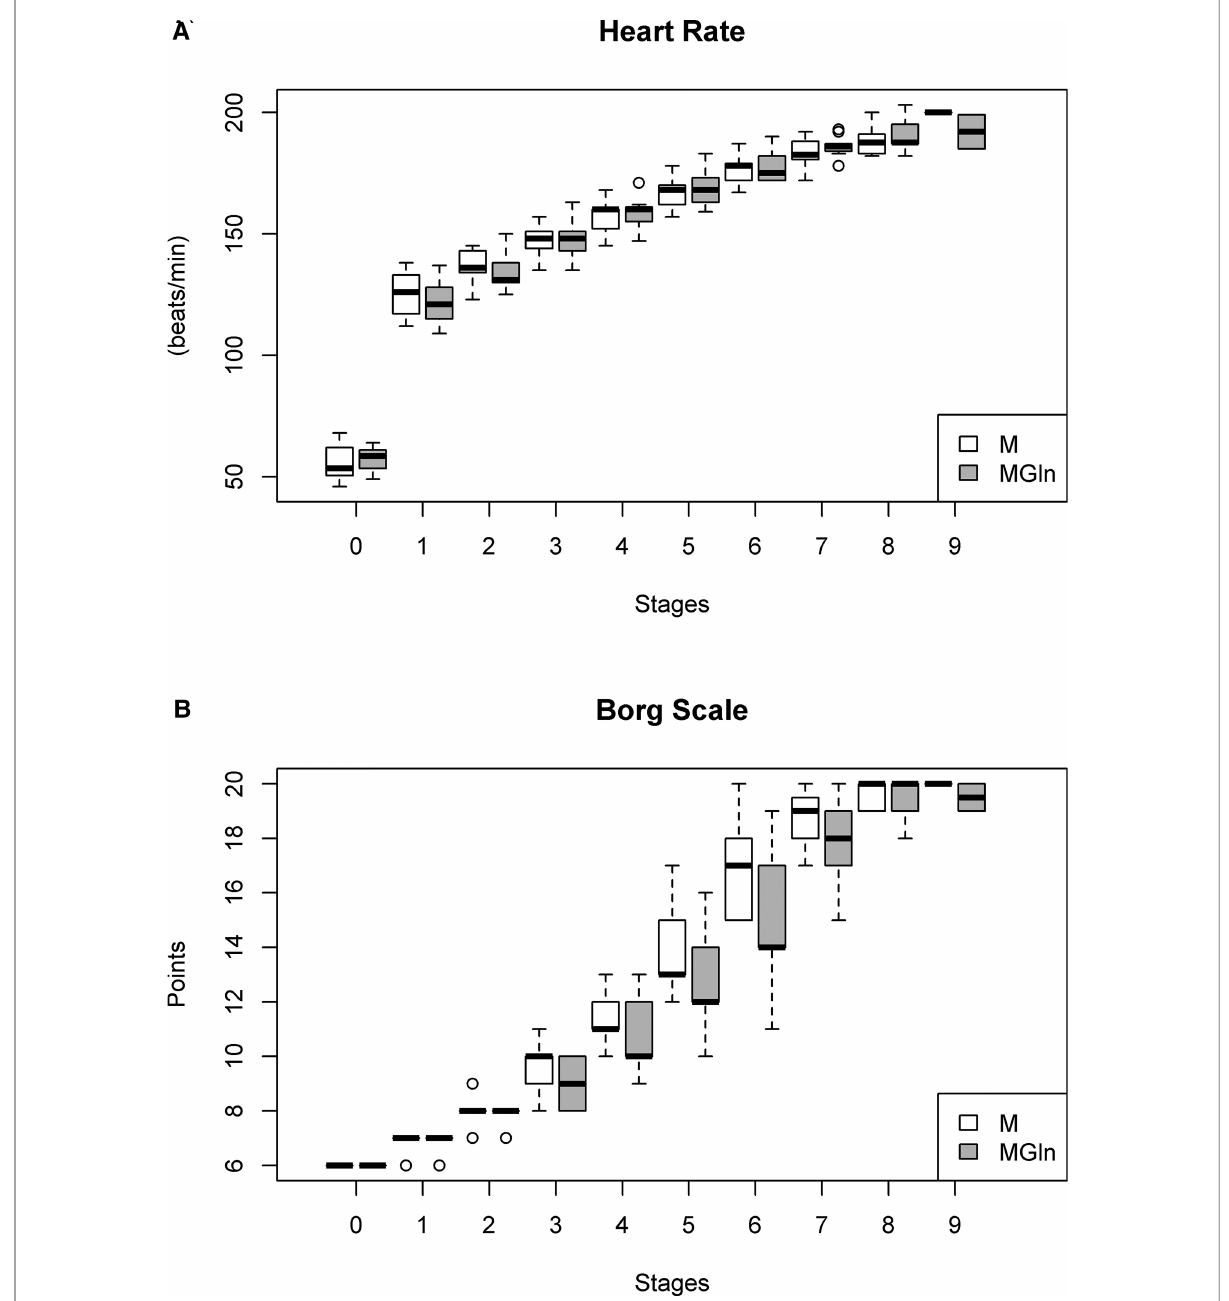
FIGURE 3 Heart rate ( A ) and borg scale ( B ) in athletes supplemented with maltodextrin (M) or maltodextrin plus hydrolyzed protein enriched with glutamine (MGln). Aerobic power and aerobic capacity tests were performed on a motorized treadmill. The athletes rested for 2 min, and their heart rate was determined. Then the athletes exercised for 3 min at 6, 7, and 8 km/h, one minute for each velocity. The test was initiated at 9.4 km/h (stage one), and the speed was increased by 1.4 km/h every 3 min until volitional fatigue was reached. The athletes ran on a 1% grade, and oxygen consumption (VO 2 ) was continuously measured. The subjective perception of the effort was determined for each stage using Borg ’ s 15-point linear scale rating of perceived exertion. For both tests, a signi fi cance level of 0.05% was